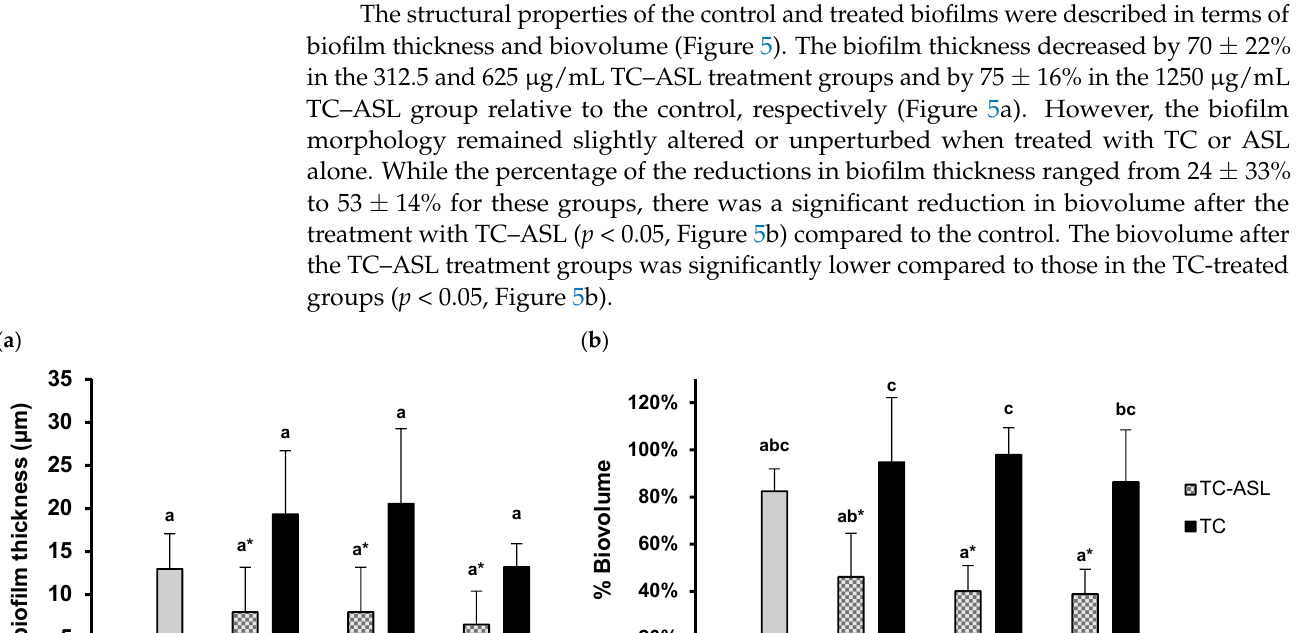
Figure 4. Biomass of E. faecalis biofilm after treatment with TC–ASL, TC, and ASL. The biomass of treated biofilm was expressed relative to control (100%). The results represent the mean ± SD of three replicates in independent experiments. Different letters denote a statistically significant dif- ference ( p ≤ 0.05) between different treatment groups while the same letters show no statistical dif- ference ( p > 0.05) between different treatment groups, including the within-group comparison and between-group comparison. * Denotes a significant difference compared to the control ( p ≤ 0.05).